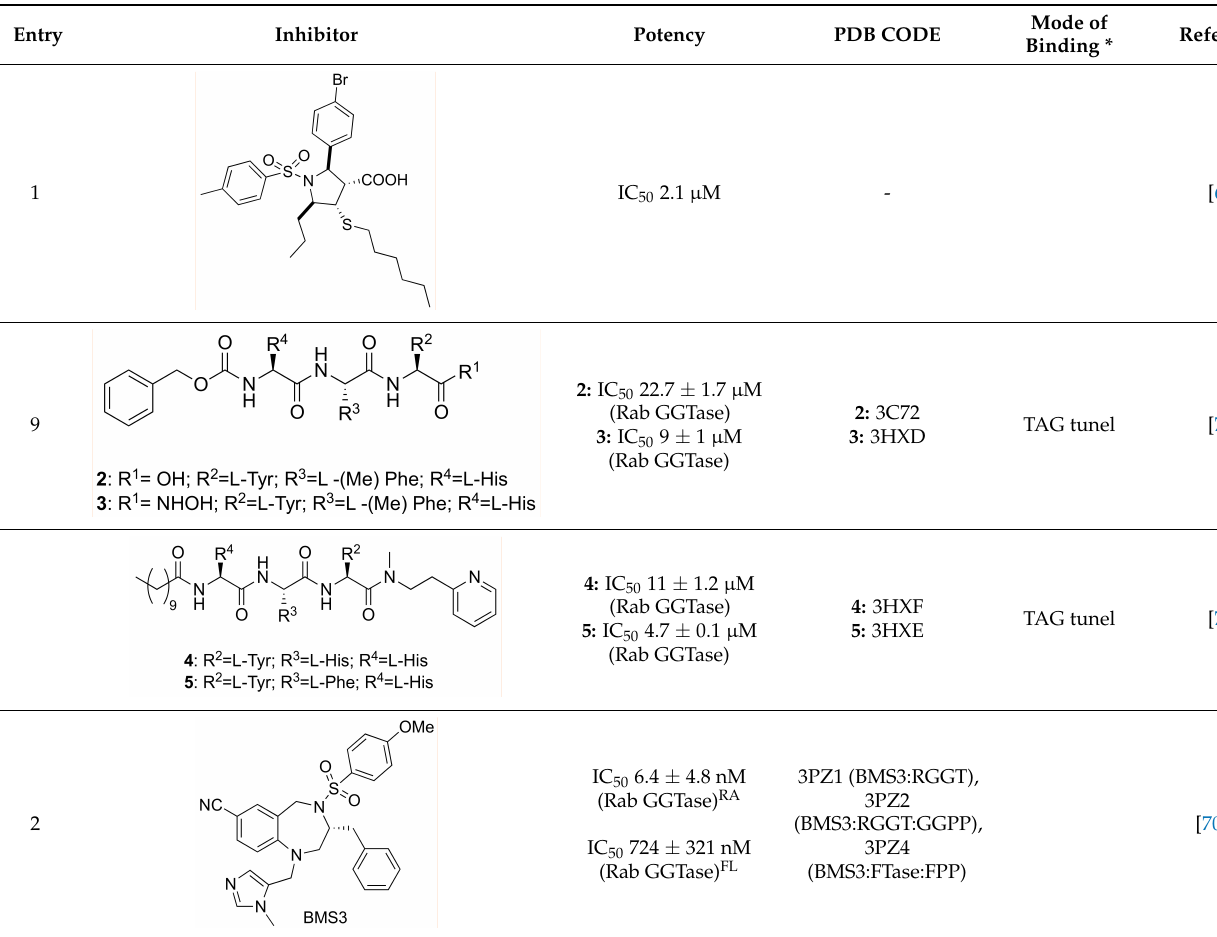
Table 5. Selected inhibitors of Rab